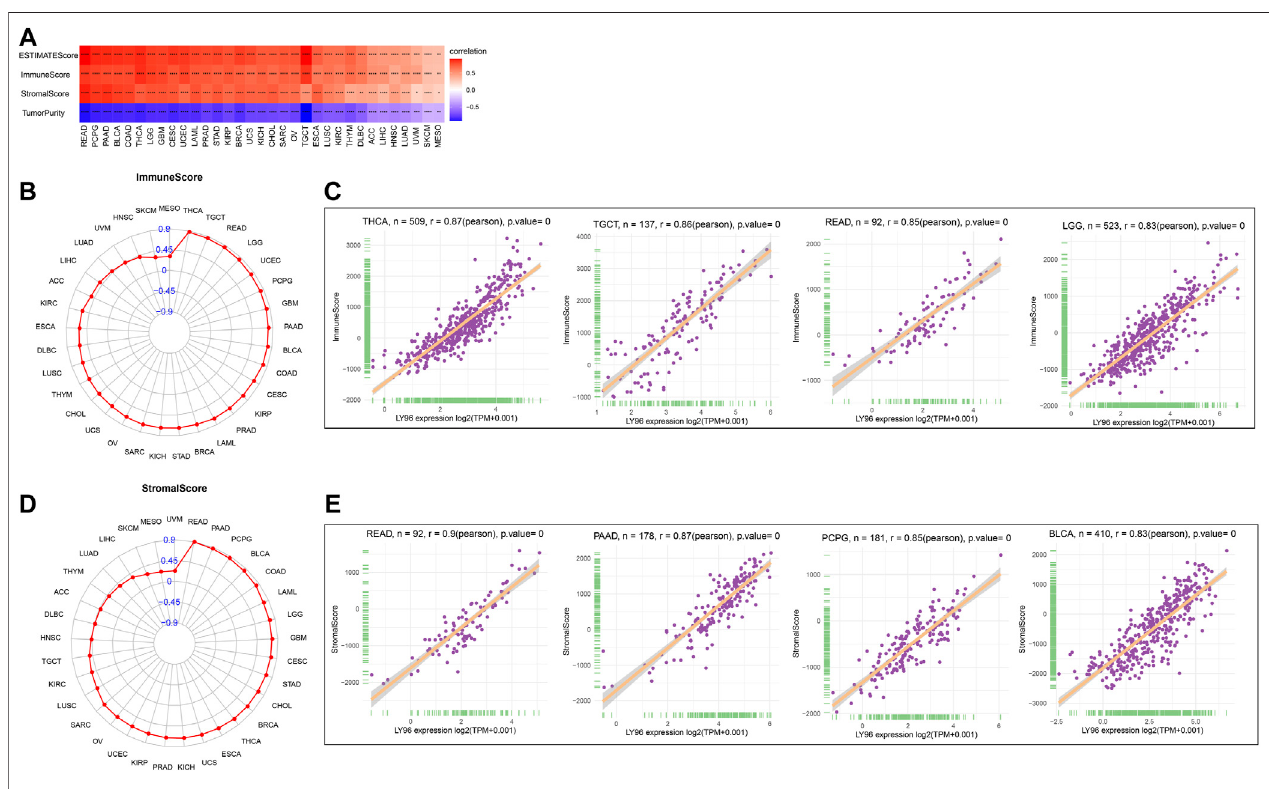
FIGURE 11 | Correlation between LY96 expression and ESTIMATE score. (A) Correlation between LY96 expression and ESTIMATE score across cancers. (B) Correlation between LY96 expression and immune score across cancers. (C) Top 4 correlated cancers in terms of LY96 expression and immune score. (D) Correlation between LY96 expression and stromal score across cancers. (E) Top 4 correlated cancers in terms of LY96 expression and stromal